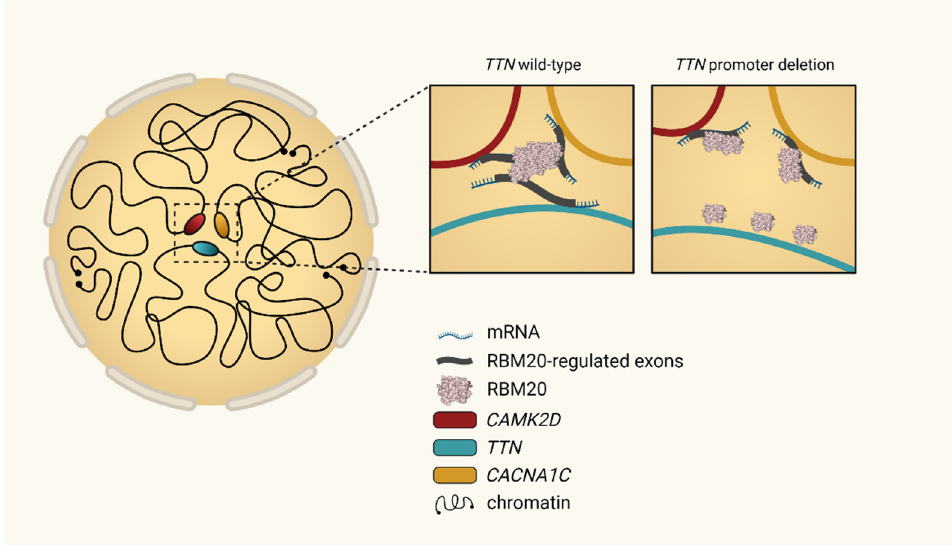
Figure 3. Modified from Bertero et al., 2019 [50]. Topological interchromosomal assembly of RBM20’s target genes. Model originally proposed by Bertero et al. to regulate local chromatin organization in human cardiomyocytes. During the differentiation of cardiomyocytes, heterochromatin becomes condensed, whereas major cardiac genes such as TTN move from the inactive (peripheral) to the active (central) compartment of the nucleus. Transcription of TTN forms foci of the splicing factor RBM20, resulting in a trans-interacting chromatin domain (TID) in which other RBM20 target genes are also involved. This mechanism drives alternative splicing of the emerging transcripts and can be interrupted by alteration of TTN transcription [50].